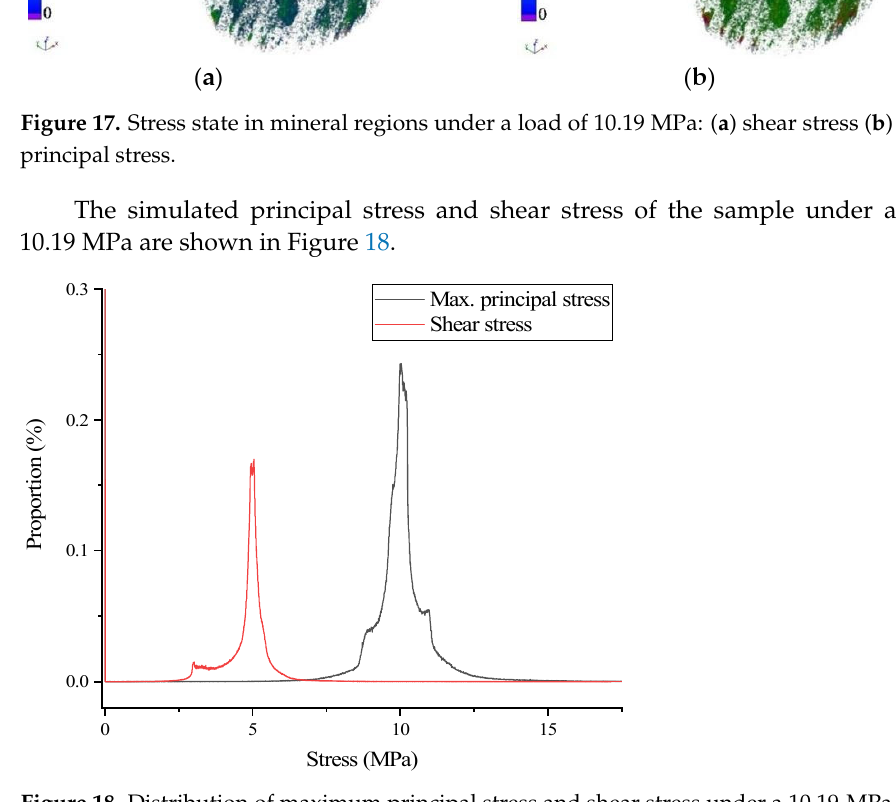
Figure 18. Distribution of maximum principal stress and shear stress under a 10.19-MPa load.